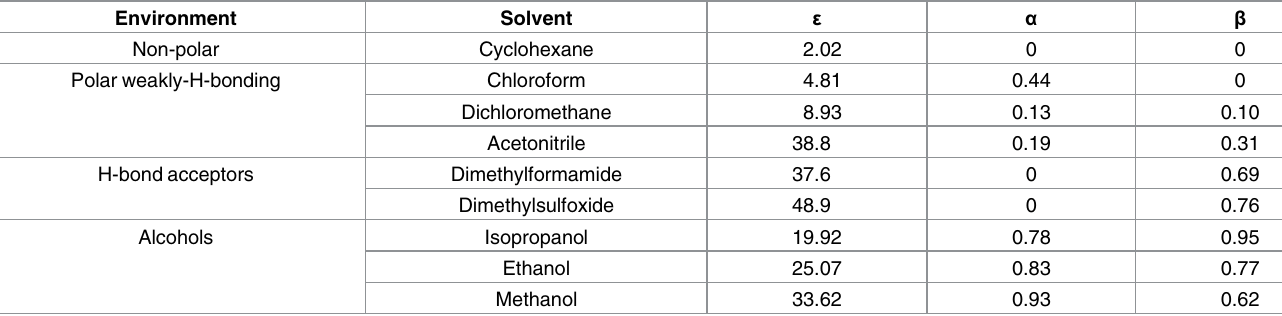
Table 1. Chemical-physical properties of the used solvents.